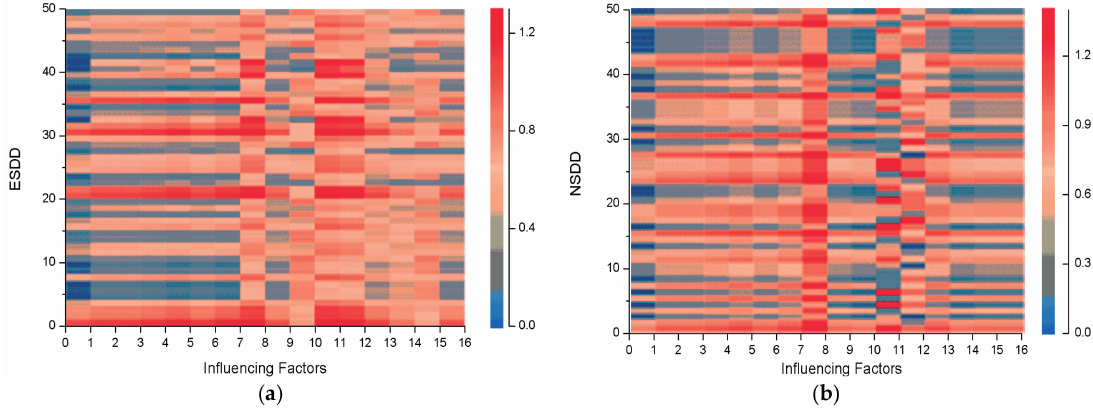
Figure 5. The thermal map. ( a ) ESDD; ( b )